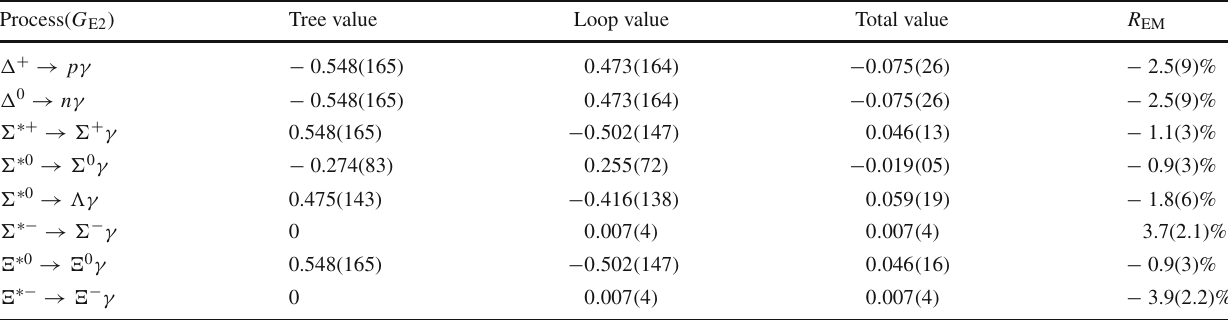
Table 6 Electro quadrupole transition moments(in unit of 1) Process( G E2